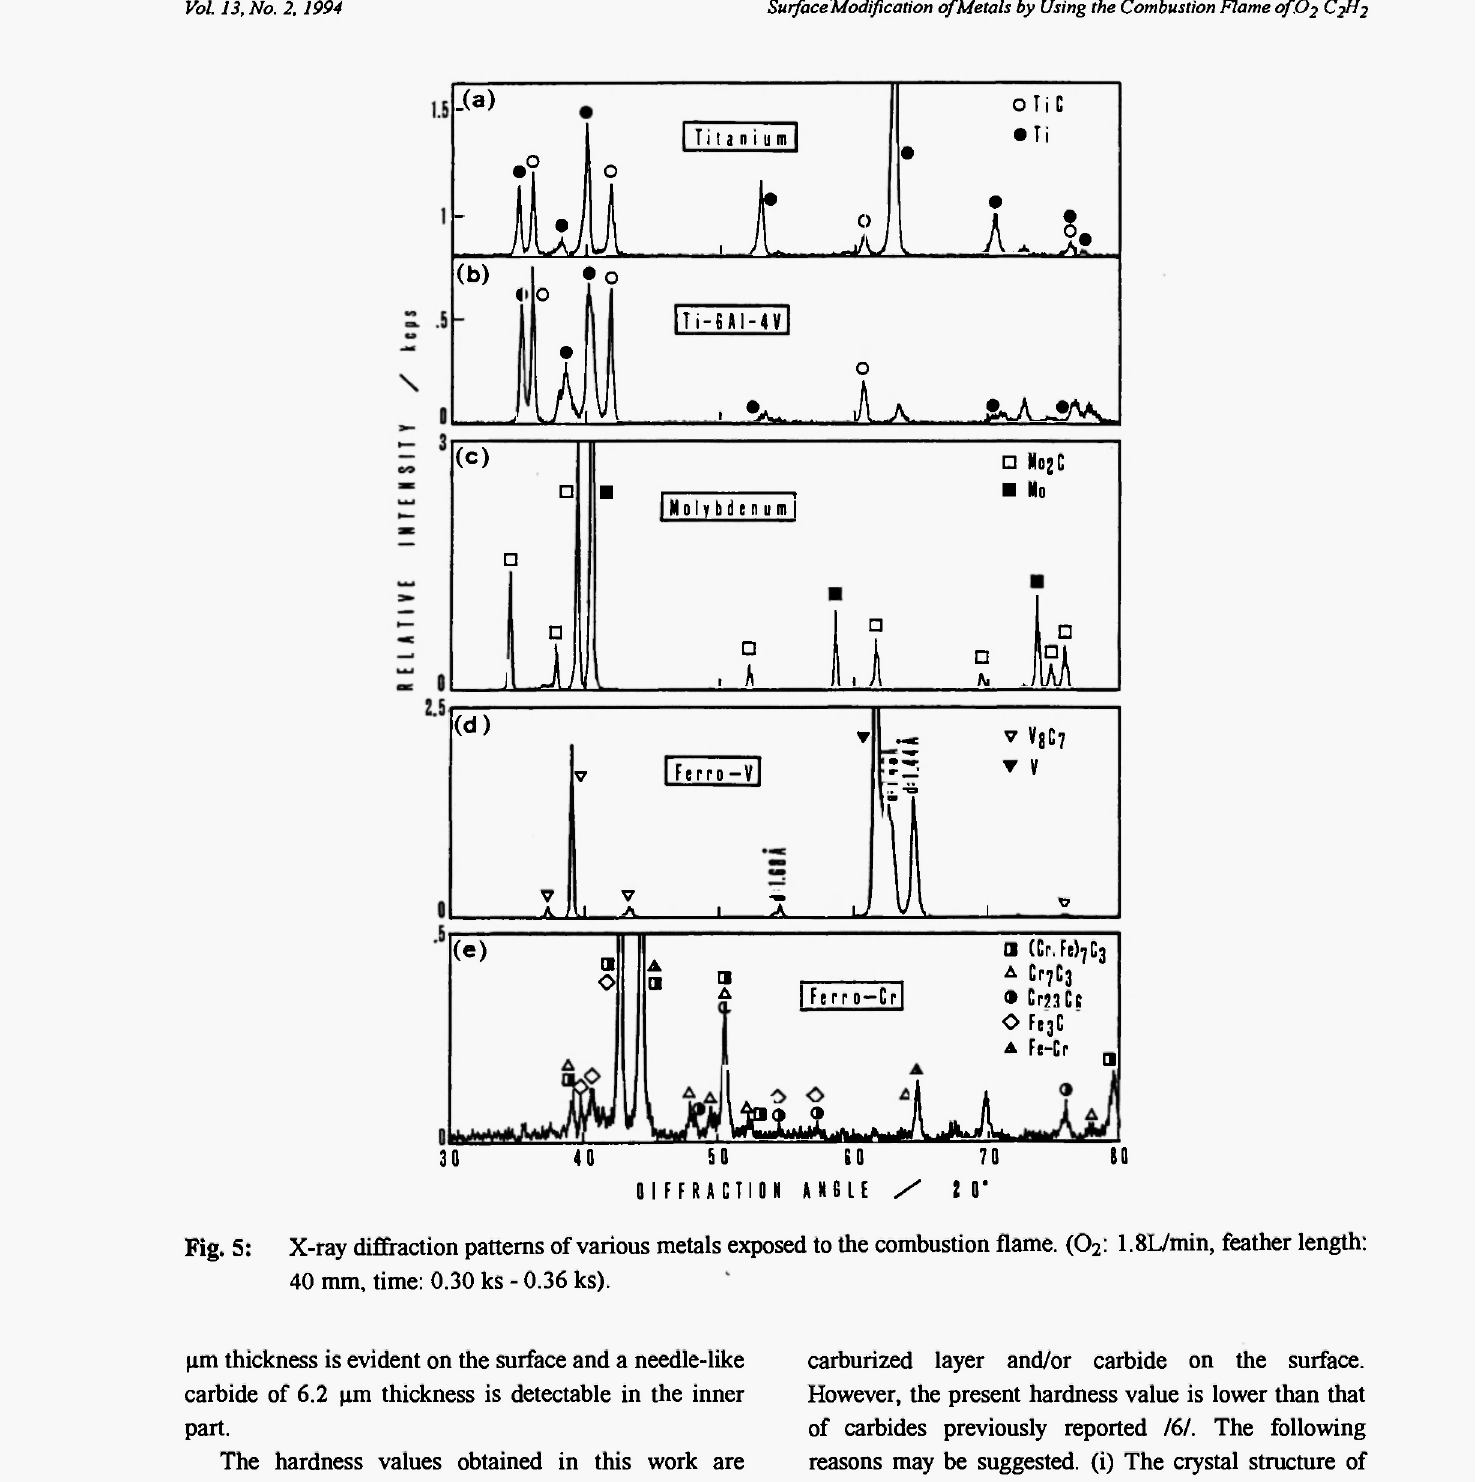
Fig. 5: X-ray diffraction patterns of various metals exposed to the combustion flame. (0 2 : 1.8L/min, feather length: 40 mm, time: 0.30 ks - 0.36